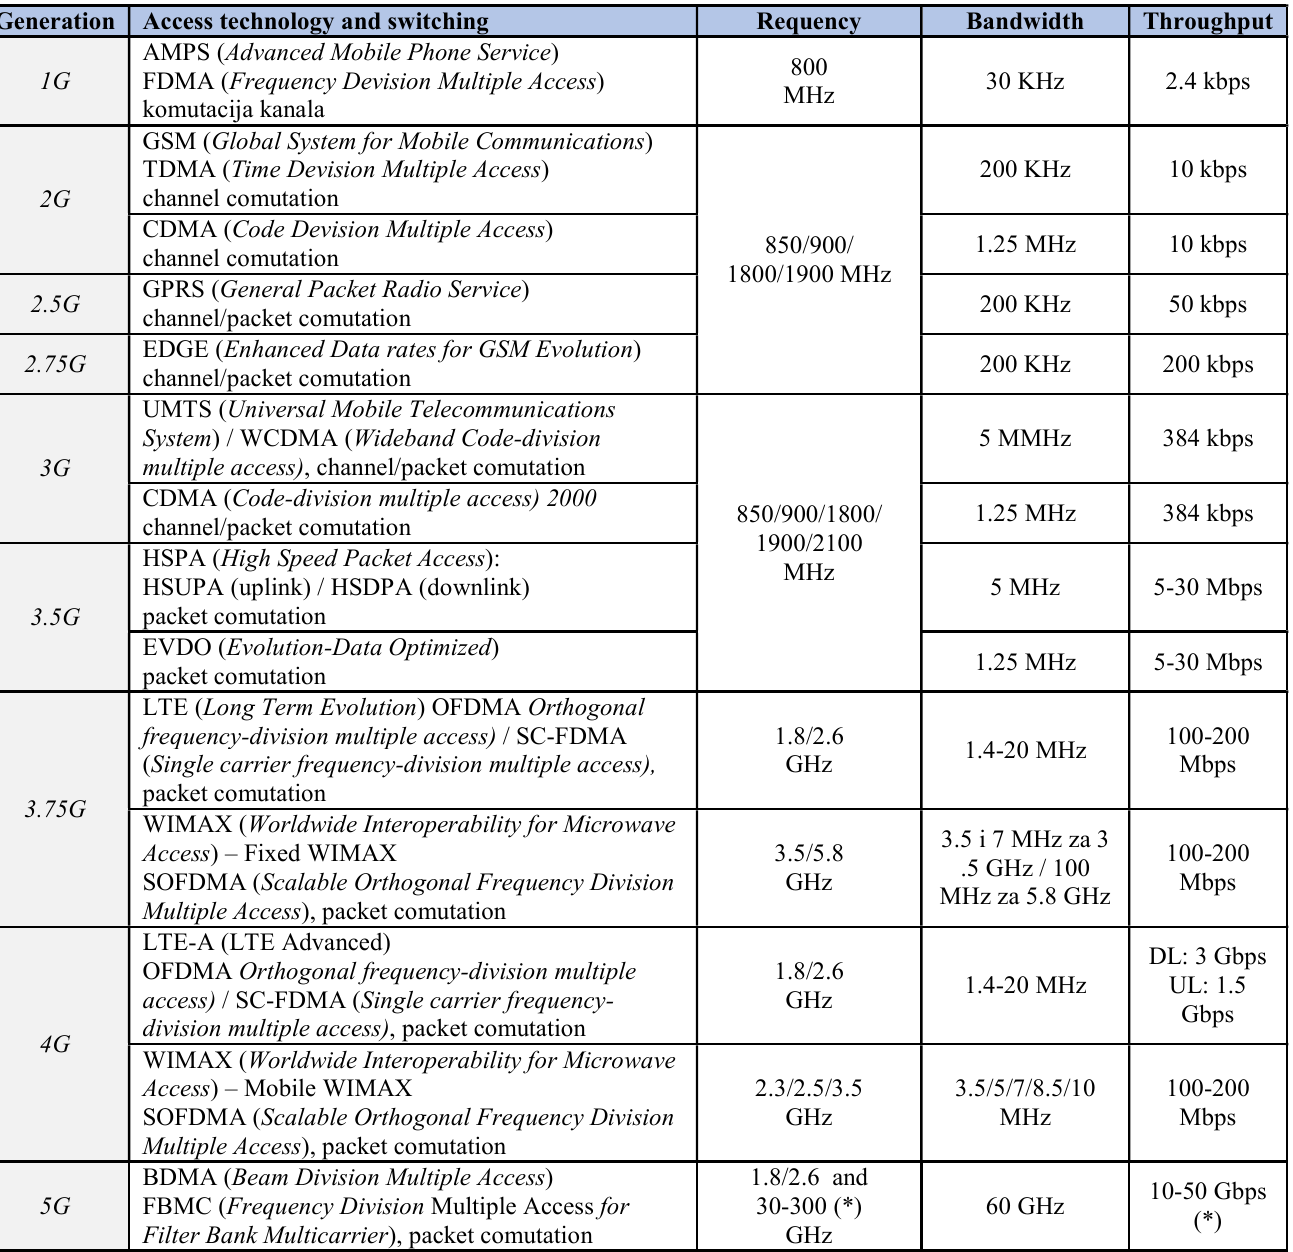
Table 7. Evolution of mobile communication technologies (1G to 5G)